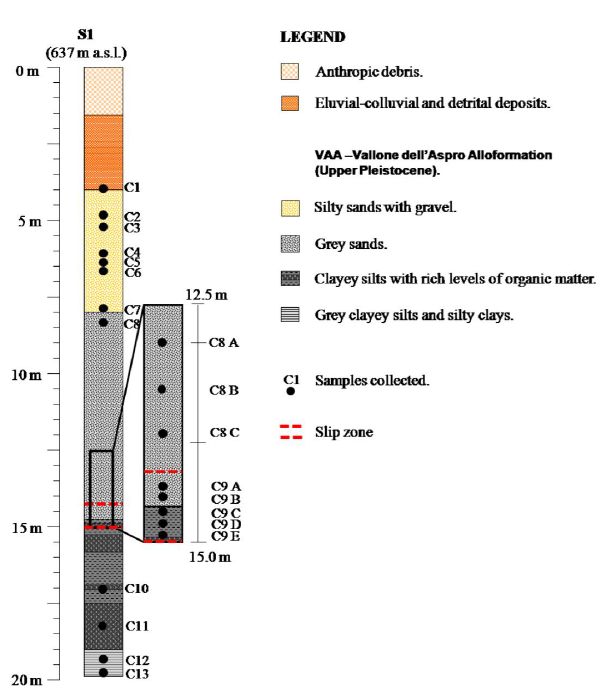
Figure 2. Stratigraphic sequence of the S1 borehole with the posi- tions of the investigated